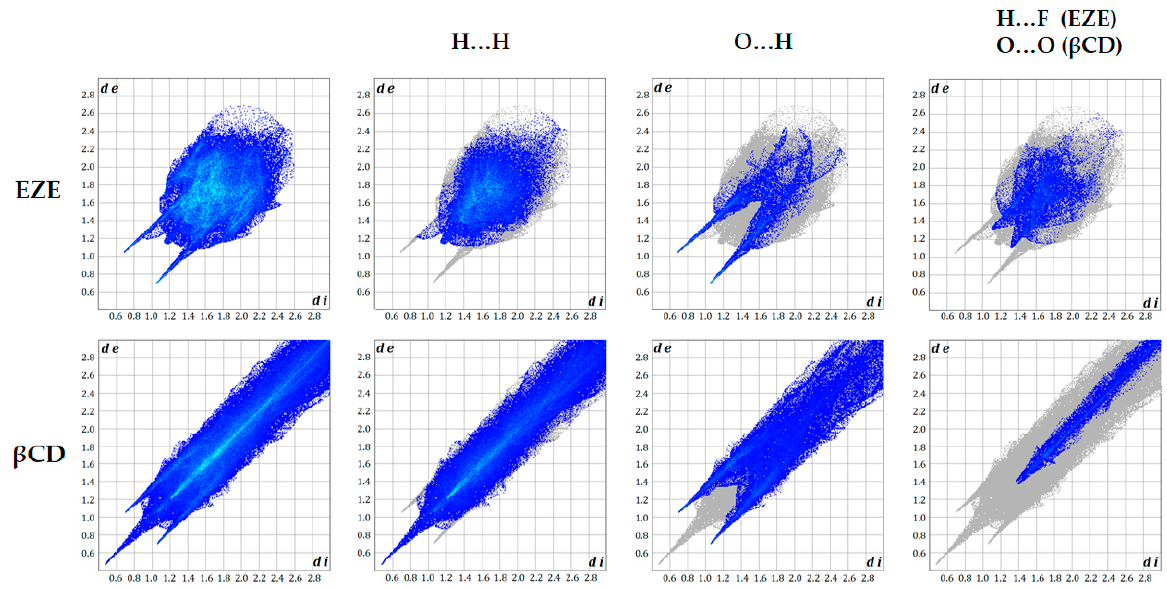
Figure 11. 2D-fingerprint plots for ezetimibe and β CD.